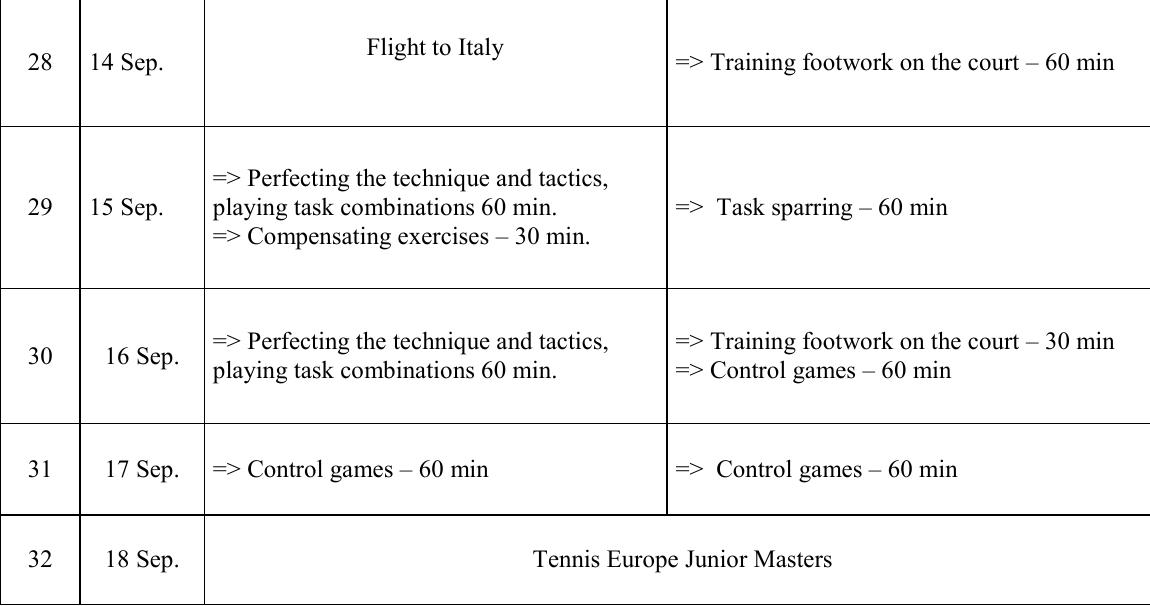
The content of training in the supercompensation phase (5 th